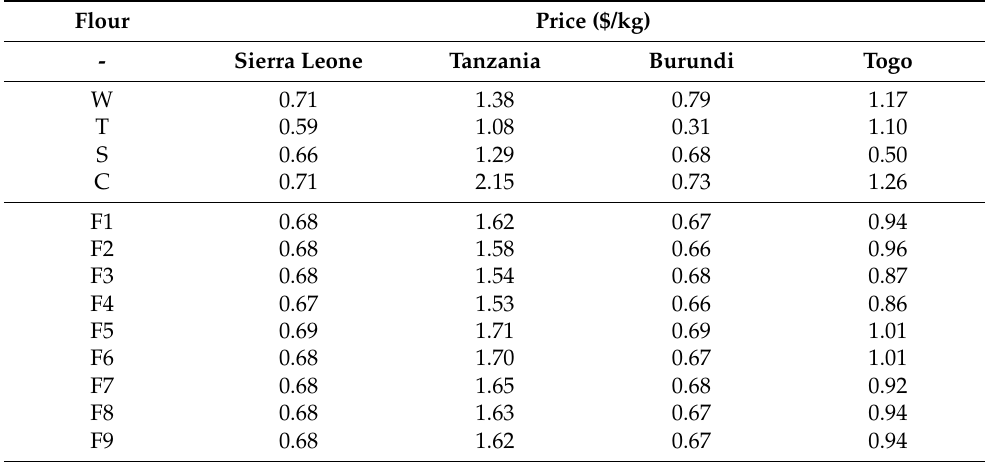
Table 4. Price ($/kg) of flatbread formulations based on raw material (W, T, S, and C flours) costs in Sierra Leone, Tanzania, Burundi, and Togo. W, wholewheat flour; T, tapioca; S, unsprouted sorghum flour; C, cowpea wholemeal flour. Flour Price